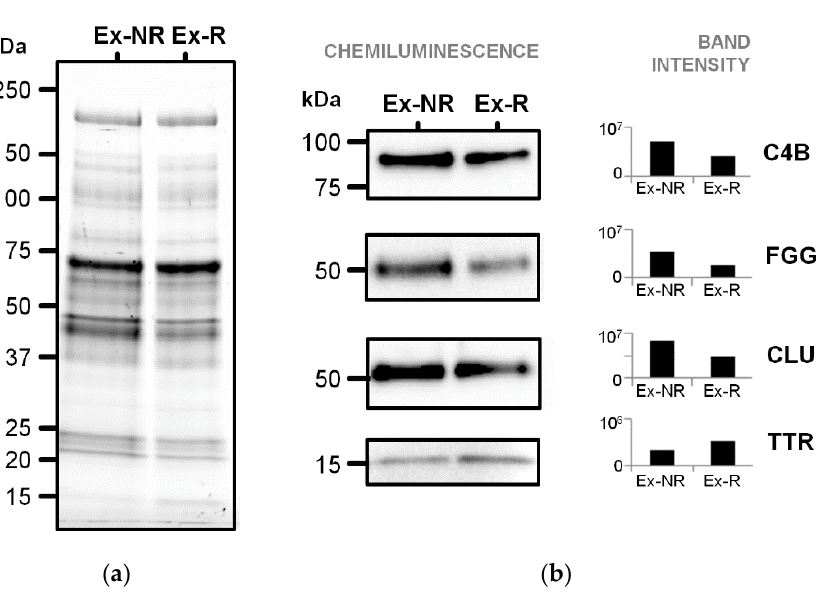
Figure 6. Immunoblotting detection of four differential plasma EV proteins (gene names on the right) of non-relapsed and relapsed pediatric HL patients. ( a ) Image of the stain-free 1DE gel (15 μ g protein/lane) upon excitation with the Chemidoc system before its transfer to the nitrocellulose membrane. ( b ) Chemiluminescence signals of bands cross-reacting with the antibodies and their intensities calculated with the Image LabTM software. Ex-NR, exosomal proteins of non-relapsed HL; Ex-R, exosomal proteins of relapsed HL.